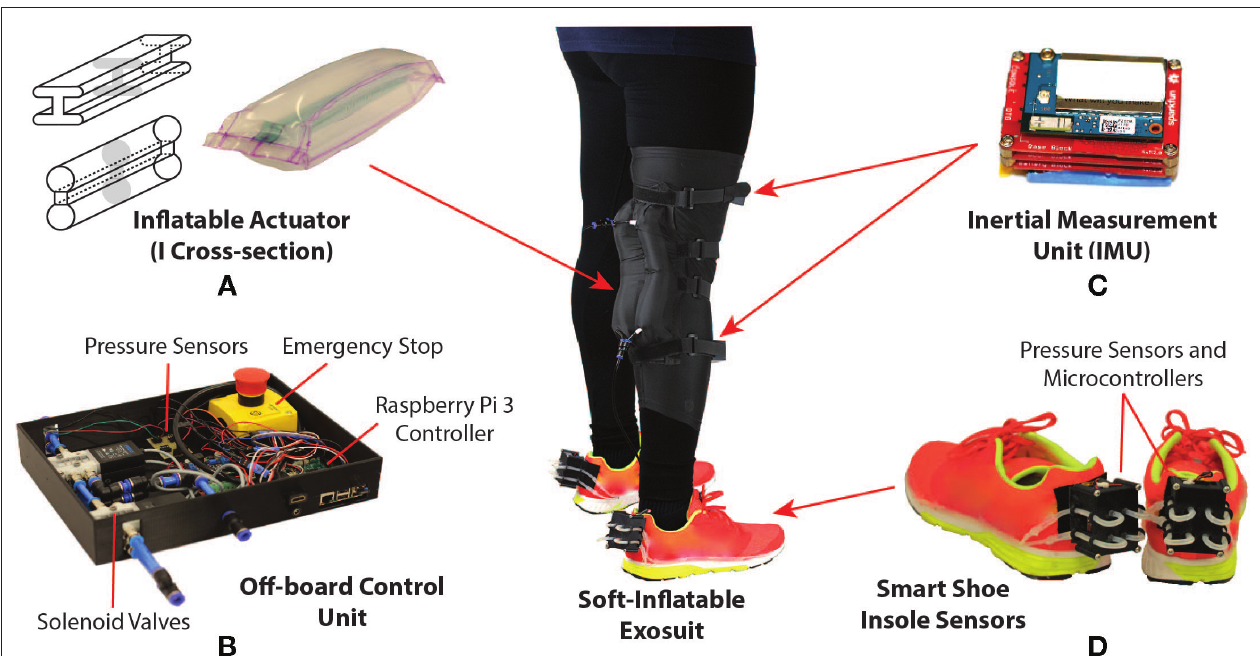
Figure 2 | Design of the soft-inflatable exosuit (a) Inflatable actuators of I cross-section designed using heat sealable TPU material. (B) Off-board control unit containing solenoid valves, Raspberry Pi 3 controller, voltage regulators and emergency stop. (c) Inertial measurement unit mounted on the exosuit to measure knee angle. (D) Smart shoe insole sensors to determine gait phases during